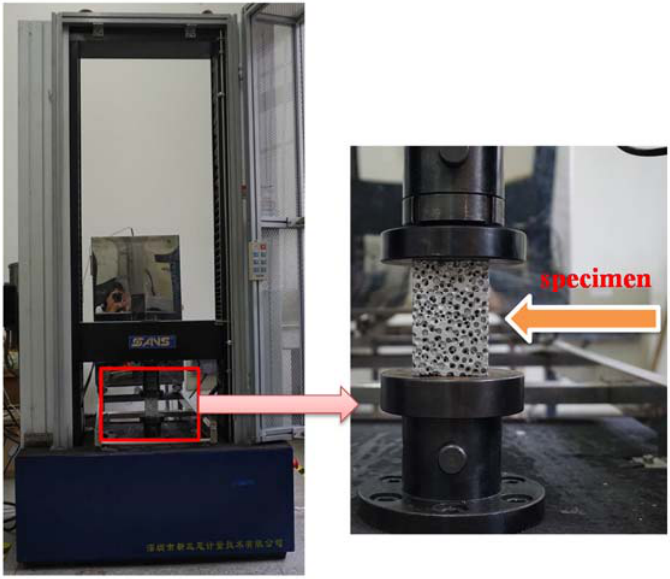
Figure 2. Uniaxial compression tests utilizing CMT5105 electron universal testing machine.